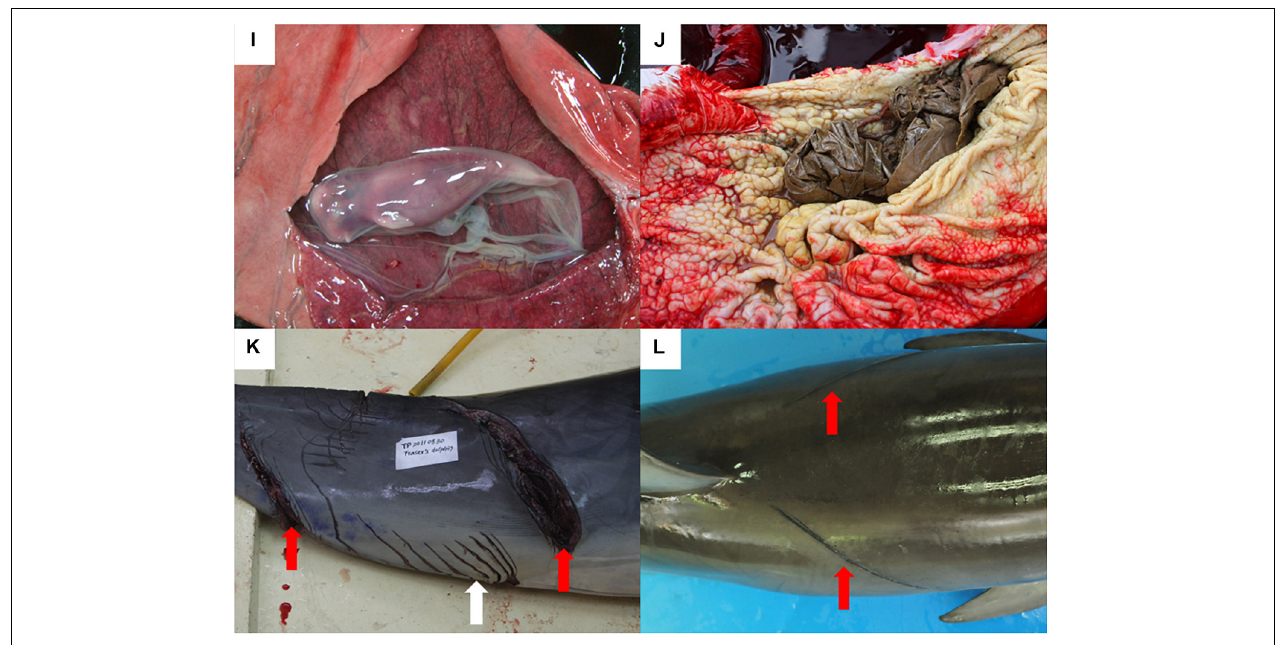
FIGURE 1 | Continued Examples of descriptive terms in stranded cetaceans in Taiwan. Viral infection: warts/plaques on the mucosa of penis and genital opening (arrows) (A) ; parasite infestation: severe parasite infestation (arrows) (B,C) and mild parasite infestation (arrows) (D) ; shark attack: severe wounds caused by sharks (E,F) ; maternal separated calf: calf with hair follicles (red arrow) and marginal papillae (white arrow) (G) ; unhealed umbilical cord (red arrow) (H) ; pregnant individual: fetus in uterus of stranded cetacean (I) ; gastrointestinal foreign bodies: non-prey items in stomach (J) ; human-related traumas: sharp trauma (red arrows). White arrow: inter/intraspecific traumatic interactions (K); and linear impressions (red arrows) (L)